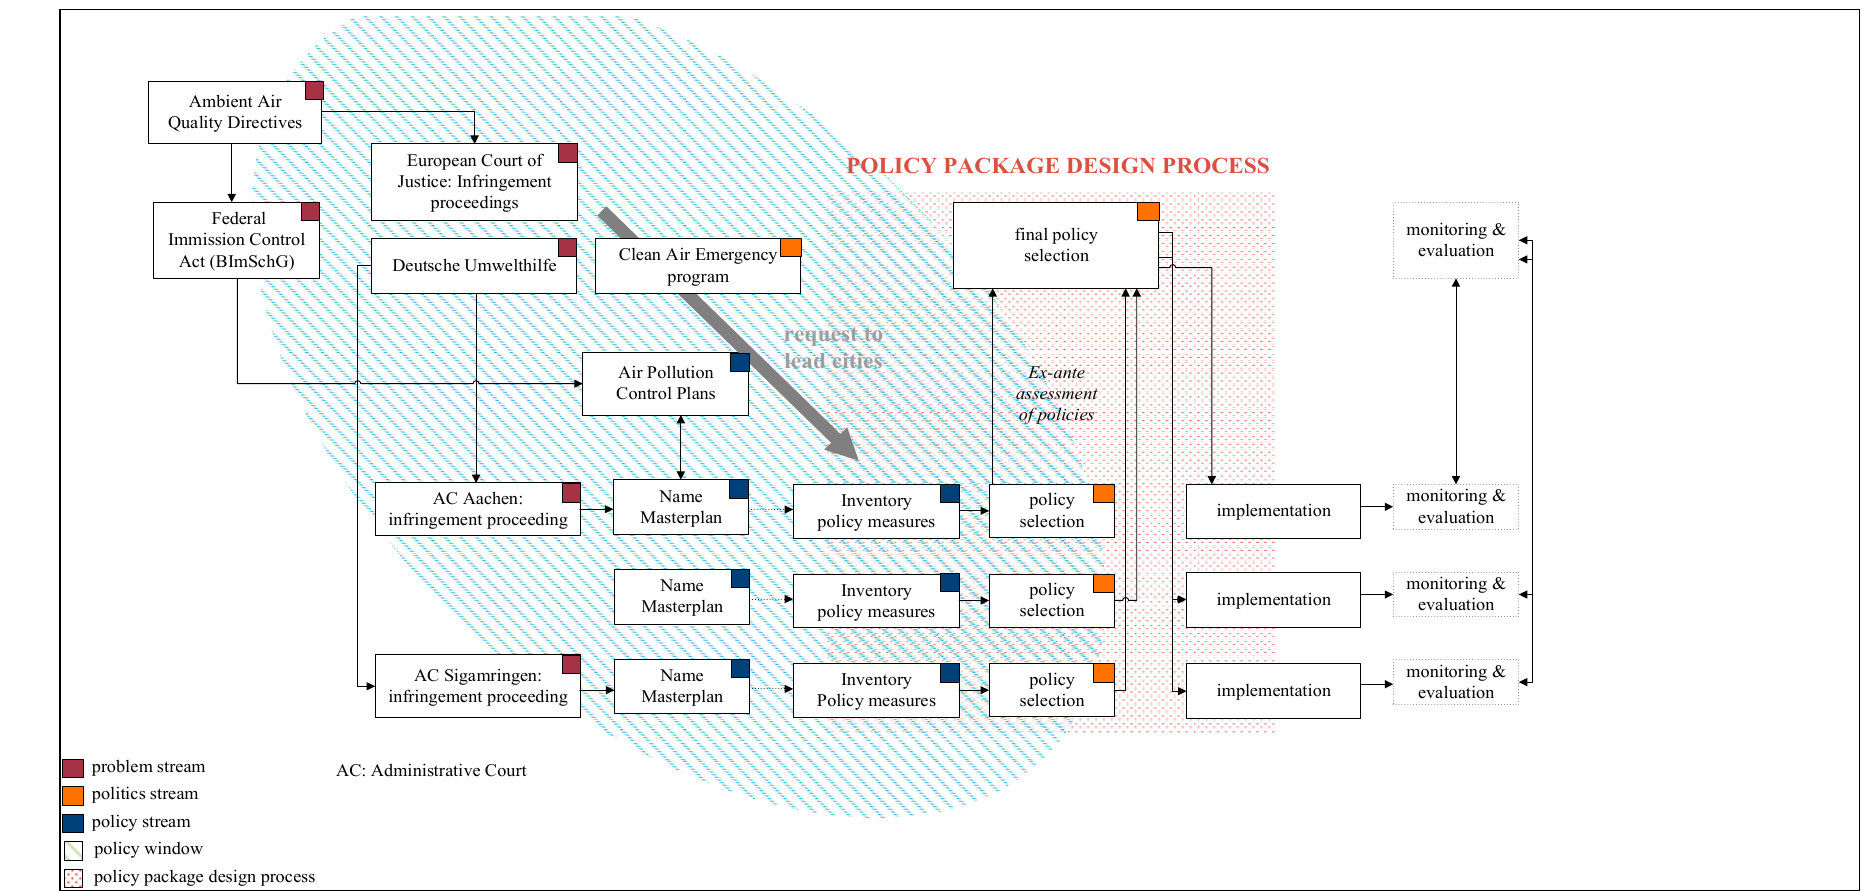
Figure 2. Multiple streaming and policy packaging in the Lead City case study. Source: own compilation.